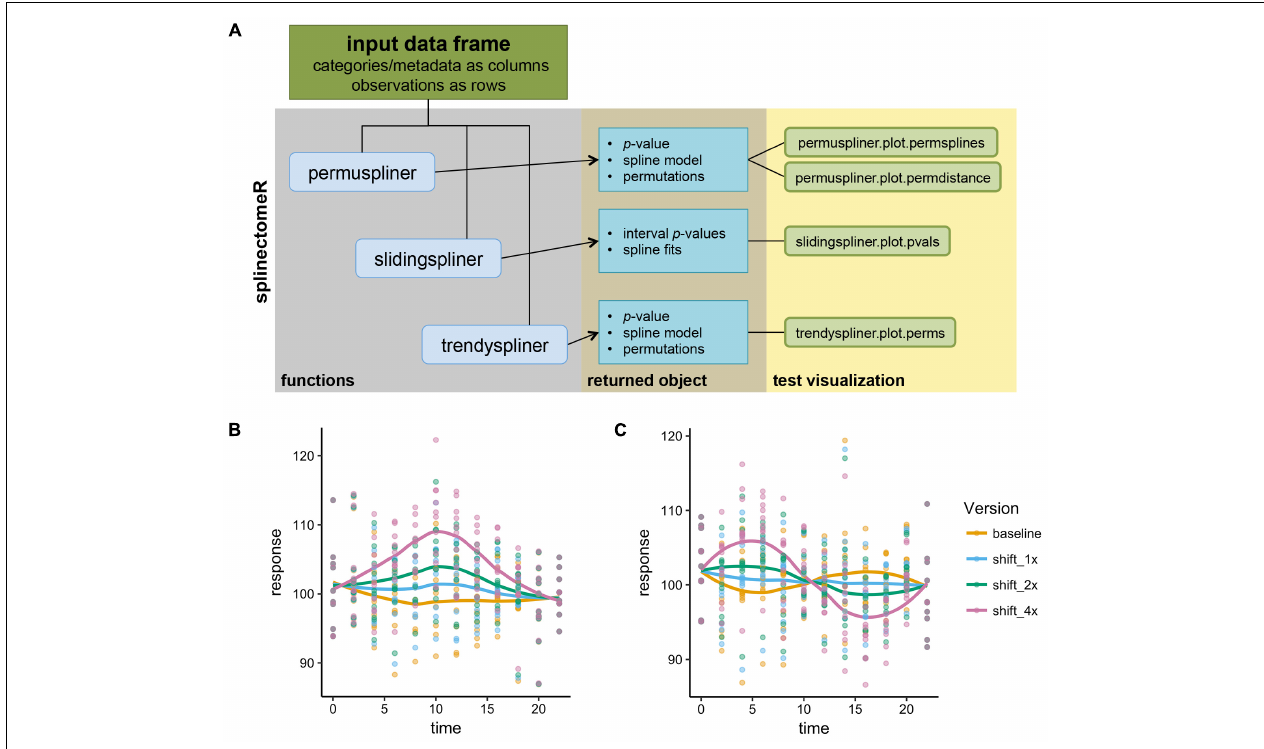
FIGURE 1 | Schematic of the splinectomeR analysis package and simulated analyses. (A) Each of the three primary tests produces a results list object containing several data articles including the p -value(s), and which can also be used to generate pre-configured data visualizations. To demonstrate that the splinectomeR package detects non-linear changes between groups during a time series, data were simulated for 10 individuals over time and perturbed at three magnitudes (1x, 2x, 4x). The perturbation was done at one (B) or two (C) regions of the time series The permuspliner test finds that these changes are less likely to be random as the magnitude increases, as would be expected. In (B) , p = 0.3, p = 0.005, and p = 0.001 for 1x, 2x, and 4x shifts, respectively; in (C) p = 0.79, p = 0.36, and p = 0.002 for 1x, 2x, and 4x shifts,